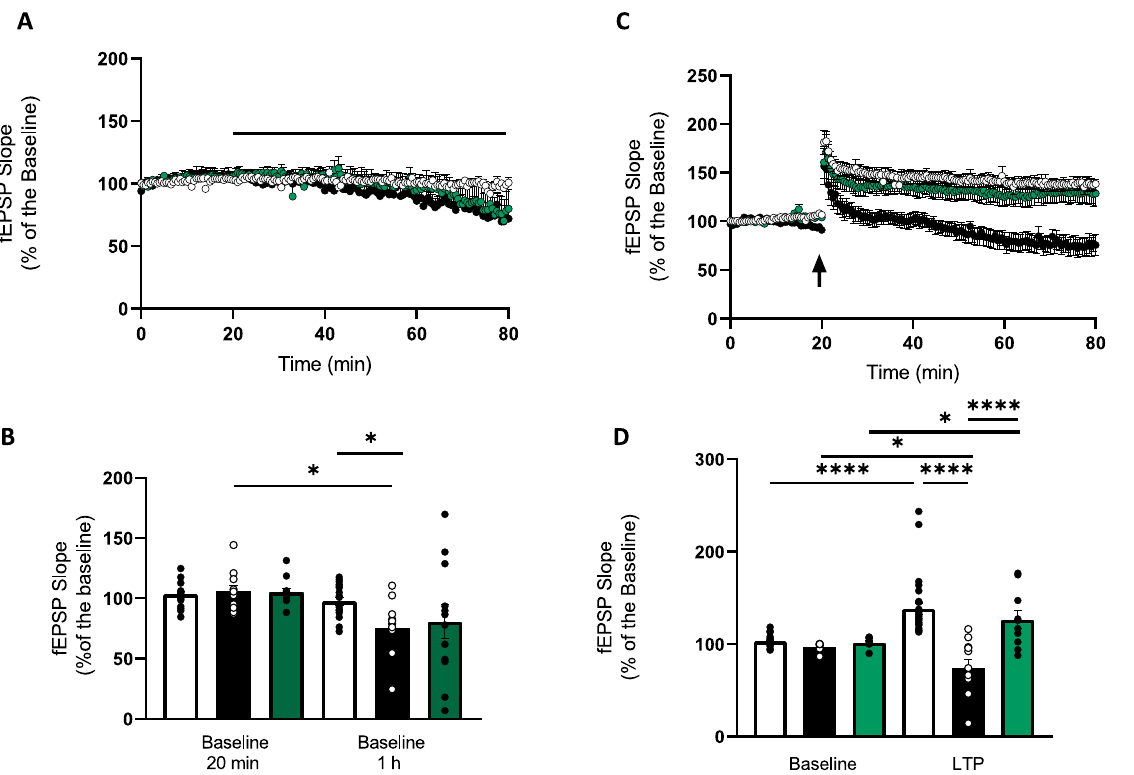
Figure 1. The e ff ects of MnTMPyP on synaptic transmission and plasticity. ( A ) Time-course showing changes in CA1 fEPSP baseline slope over 1 h for controls (white circles), 2.5 µM MnTMPyP (green circles) and 25 µM MnTMPyP (black circles). In controls and 2.5 µM MnTMPyP-treated groups (2.5 µM MnTMPyP; 20 min: 105.3 ± 3.35%; 1 h: 81.9 ± 14.1%; p > 0.05; n = 11), there was no signi fi cant change in fEPSP slope over a 1 h time-course (controls; 20 min: 103 ± 2.5%; 1 h: 98 ± 3.3%; p > 0.05; n = 19). However, in the presence of 25 µM MnTMPyP, there was a signi fi cant decrease in fEPSP slope over 1 h (baseline 20 min: 105.9 ± 5.2%; baseline 1 h: 76.3 ± 7.5%; n = 11; p < 0.05). ( B ) Bar chart summarising the time-course data in A. White bars represent controls (baseline at 20 min and 1 h timepoints) at baseline (5 min on baseline transmission taken before the addition of MnTMPyP) and last 5 min of 1 h drug incubation. Black bars represent 25µM MnTMPyP at 20 min and 1 h timepoints. Green bars represent 2.5 µM MnTMPyP-treated group at the same 20 min and 1 h time points. ( C ) Time-course of fEPSP slope before and after HFS from control hippocampal slices (white circles), hippocampal slices pretreated with 25 µM MnTMPyP (dark circles) and hippocampal slices pretreated with 2.5 µM MnTMPyP (green circles). Baseline is normalised to the fi rst 20 min of con- trol fEPSP. HFS stimulation in control slices (white circles) gave rise to a robust synaptic potentiation (135.0 ± 6.1%, n = 27) after 60 min. MnTMPyP (2.5 µM, green circles) did not impair synaptic plas- ticity (121.0 ± 9.2, n = 9). However, high concentrations of the superoxide dismutase mimetic (25 µM, black circles) impaired synaptic potentiation and signi fi cantly reduced baseline synaptic transmis- sion 60 min after the HFS (74.3 ± 9.3%, n = 11). ( D ) Bar charts summarising the data in C. Control LTP (white bars), 25 µM MnTMPyP (black bars) and 2.5 µM MnTMPyP (green bars). Baseline values were taken 5 min before HFS induction. Average fEPSP slope was taken at 60 min after HFS. Arrow indicates timing of HFS. All data are expressed as mean ± SEM. * p < 0.05, **** p < 0.0001.